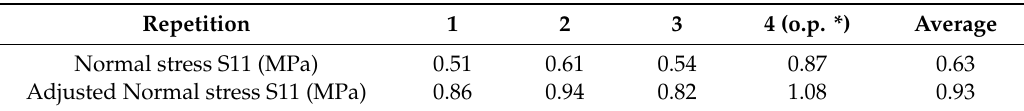
Table 12. Normal stress S11 and adjusted normal stress S11 calculated by the numerical model for all repetitions performed experimentally for mode